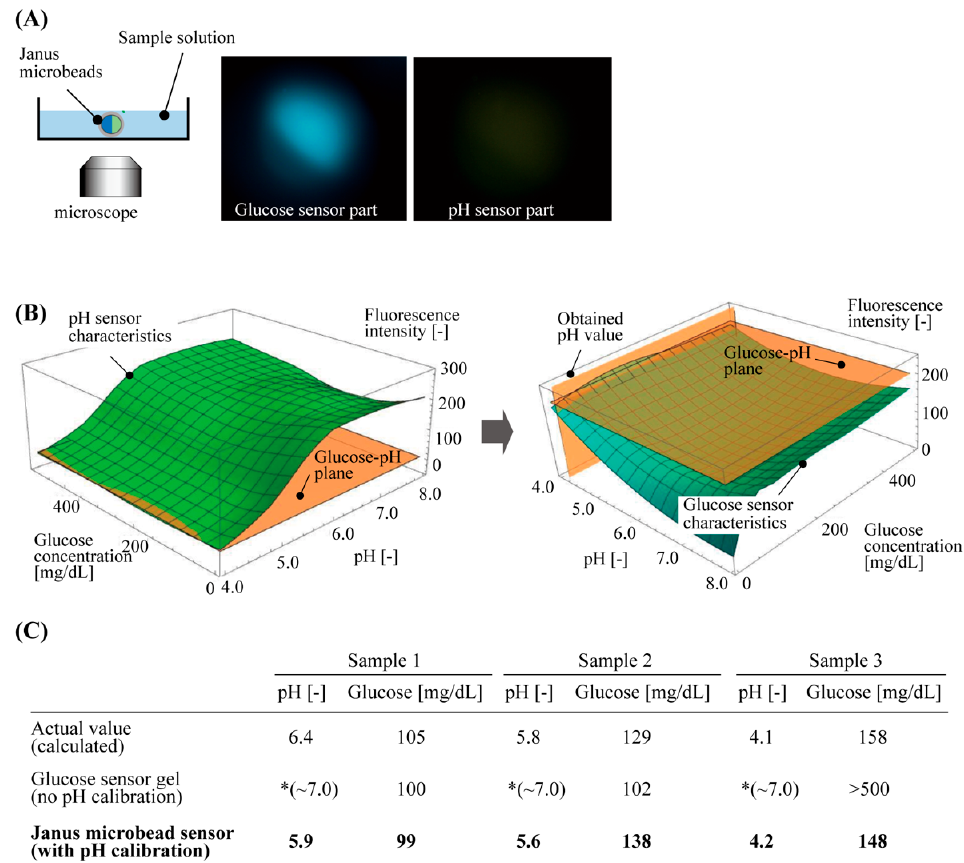
Figure 5. Demonstration of glucose concentration measurement of sample solutions by using Janus hydrogel microbeads with pH calibration. ( A ) Experimental setup and typical obtained fluorescent images of the microbeads. ( B ) Procedures for obtaining glucose concentration with the fluorescent characteristics of the Janus hydrogel microbeads. ( C ) Comparison of the values of glucose concentration obtained by actual content calculation, glucose sensor gel without pH calibration, and Janus microbead sensor with pH calibration.